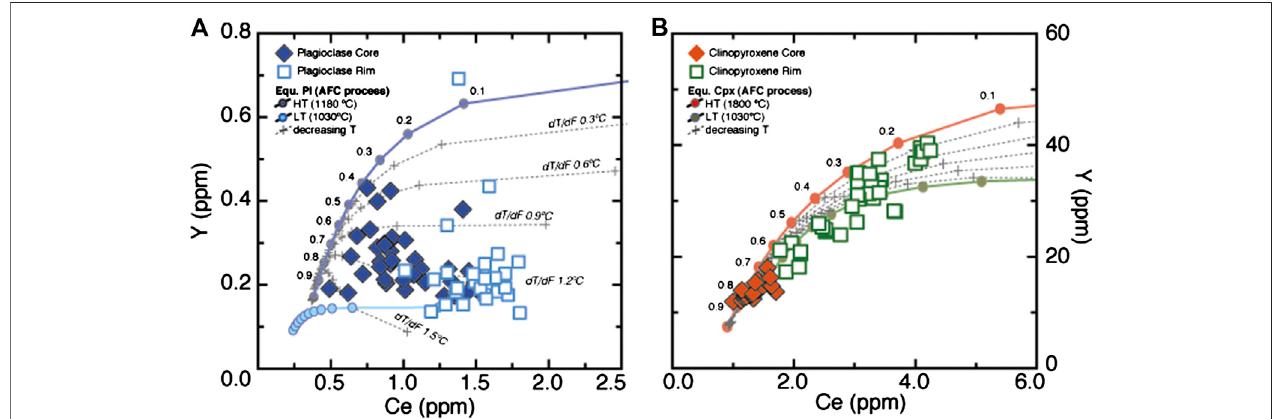
FIGURE 11 | Ce and Y (ppm) variations in plagioclase (A) and clinopyroxene (B) from our sample. Also shown are the compositions of plagioclase and clinopyroxene in equilibrium with melts produced by the process of assimilation-fractional crystallization (AFC) at different temperature conditions described herein (see text for explanation). Each symbol represents step of F (cid:1) 0.1 of the AFC process as indicated by the numbers. dT/dF indicates the decrease in temperature ( ° C) at each 1% of the AFC process. Note that the temperature control on Ce/Y covariation is strong because the temperature decrease has a major effect on plagioclase whereas the effect on clinopyroxene is